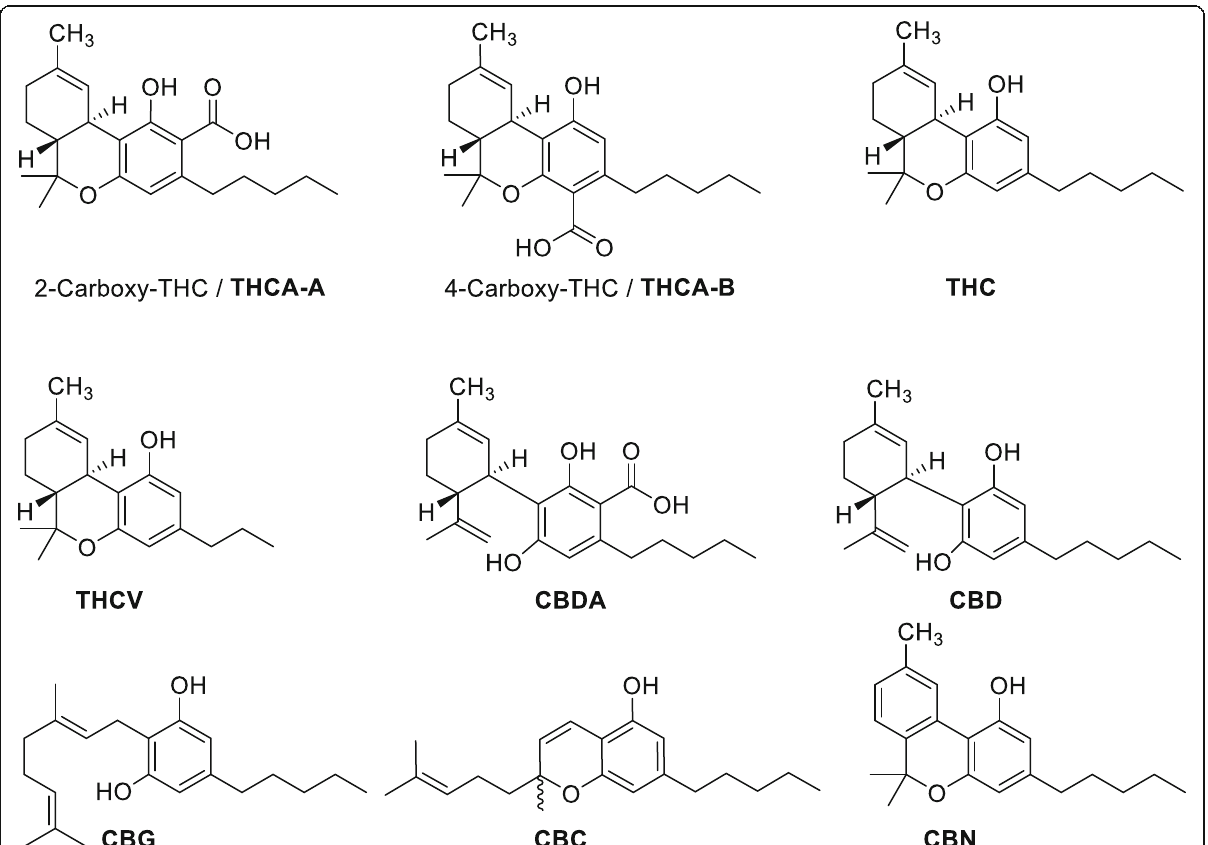
Fig. 1 Structures of important Cannabis sativa cannabinoid classes: Δ 9 -tetrahydrocannabinol ( Δ 9 -THC or THC) and its acidic counterparts (THCA- A/THCA-B), tetrahydrocannabivarin (THCV), cannabidiol (CBD) and its acidic counterpart (CBDA), cannabigerol (CBG), cannabichromene (CBC), and cannabinol